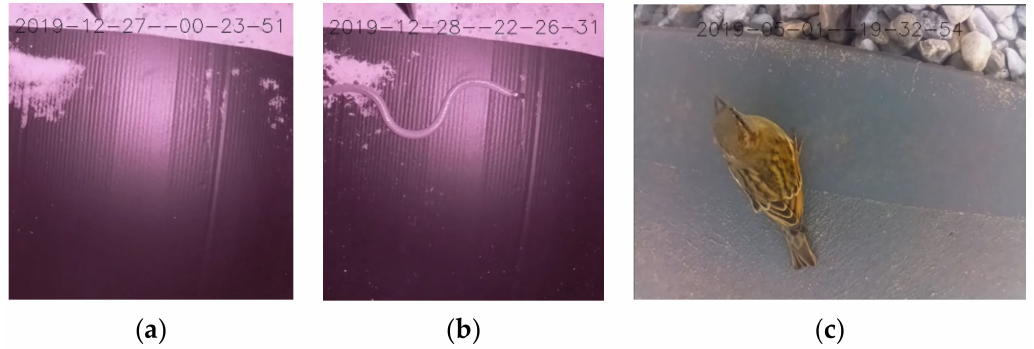
Figure 4. Footage example where ( a ) motion is not detected, ( b ) motion is detected, and ( c ) a bird is captured in good light